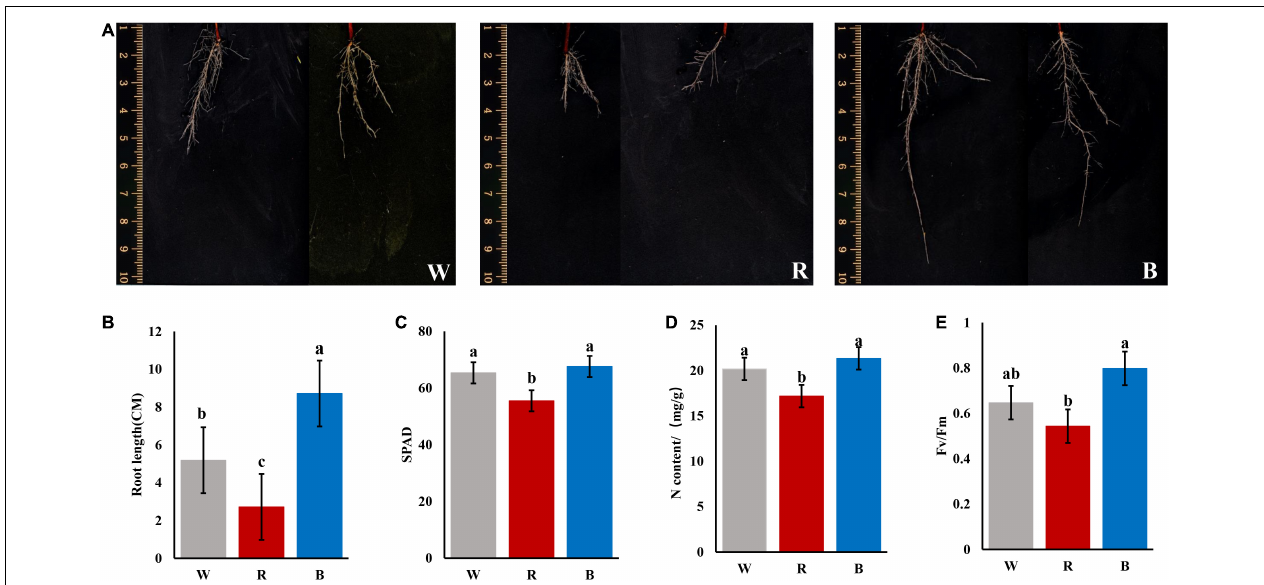
FIGURE 1 | Phenotypic and physiological indicators of cuttings under different light quality after culturing for 90 days. (A) Root phenotypes of cuttings under 3 light qualities. (B) Longest root length (unit:CM). (C) SPAD value of mature leaves. (D) N contents of mature leaves (unit: mg/g). (E) Fv/Fm ratio of mature leaves ( P <